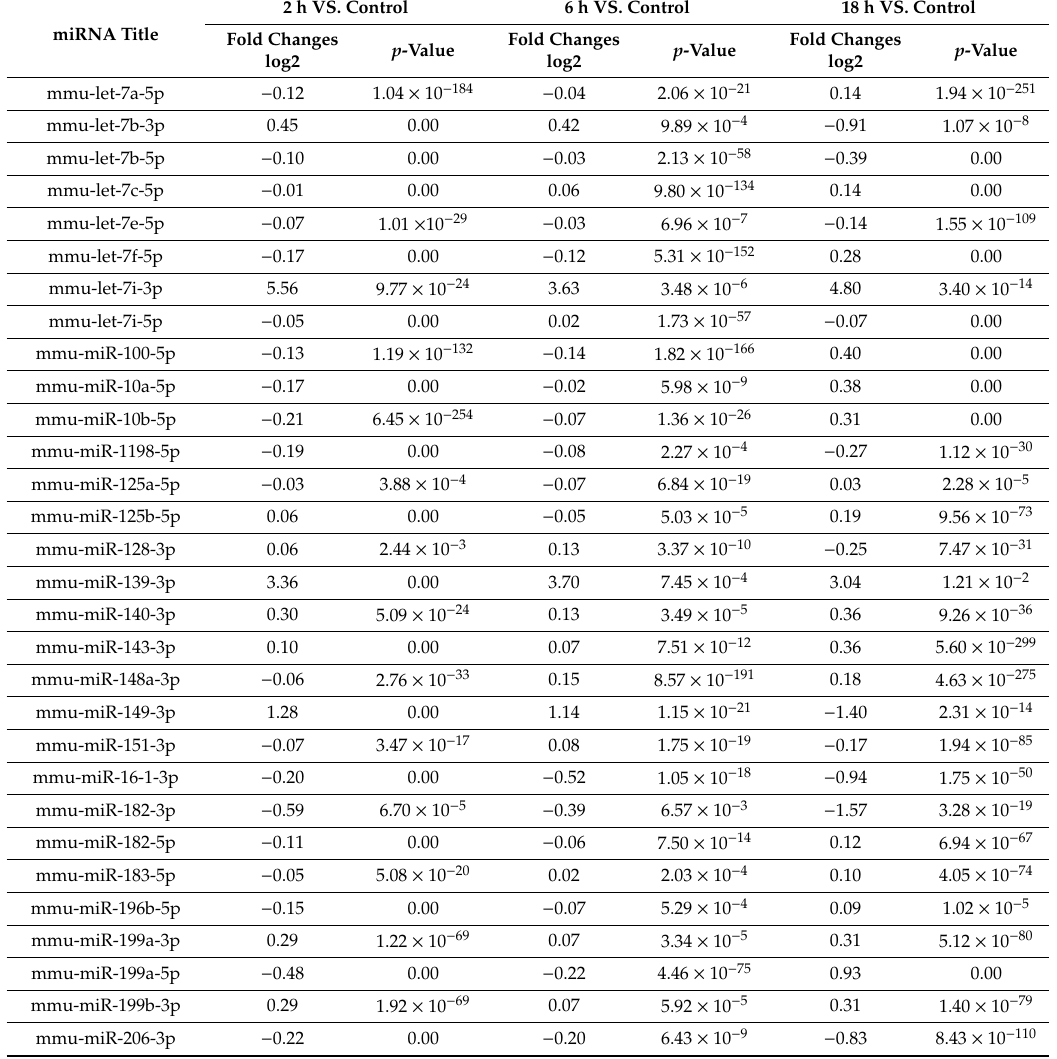
Figure 4. ( A – C ) MicroRNAs two generation sequencing data scatter diagram. ( D ) The numbers of significantly different expression miRNAs in different groups. Table 2. Differentially expressed ( p < 0.05) miRNA after treatment with 0.01 μ mol/L ZEA for different time (0, 2, 6 and 18 h).